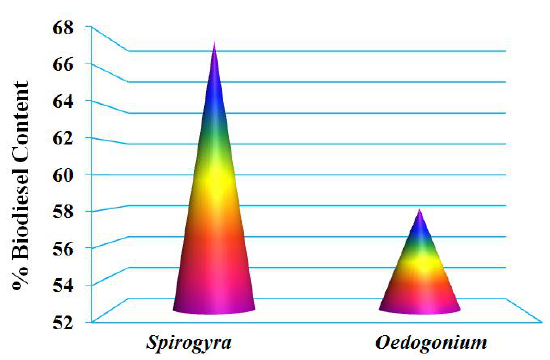
Figure 6. The Biodiesel production (% of dry weight) in Spirogyra and Oedogonium